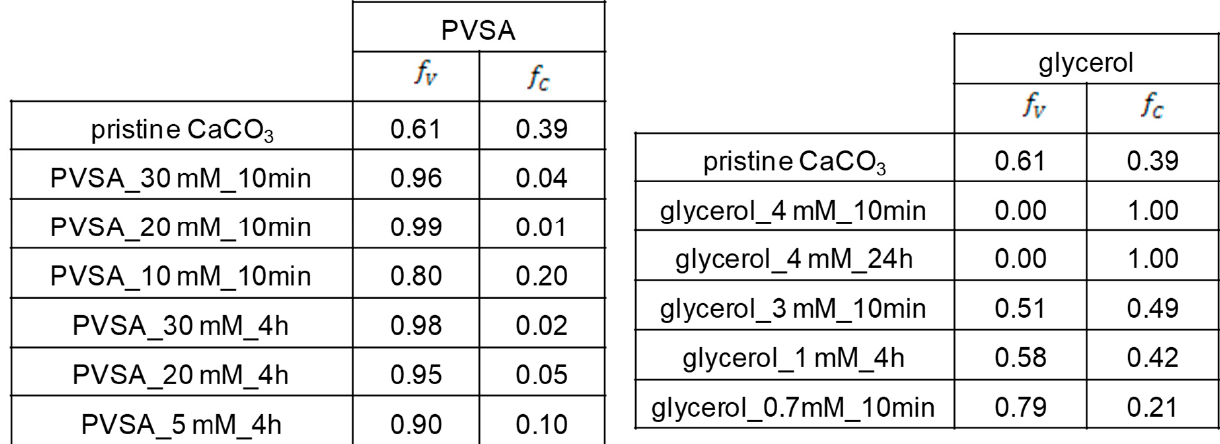
Figure 5. Relative fraction of vaterite and calcite in the hybrid CD-CaCO 3 particle. f v : fraction of vaterite; f c : fraction of calcite.